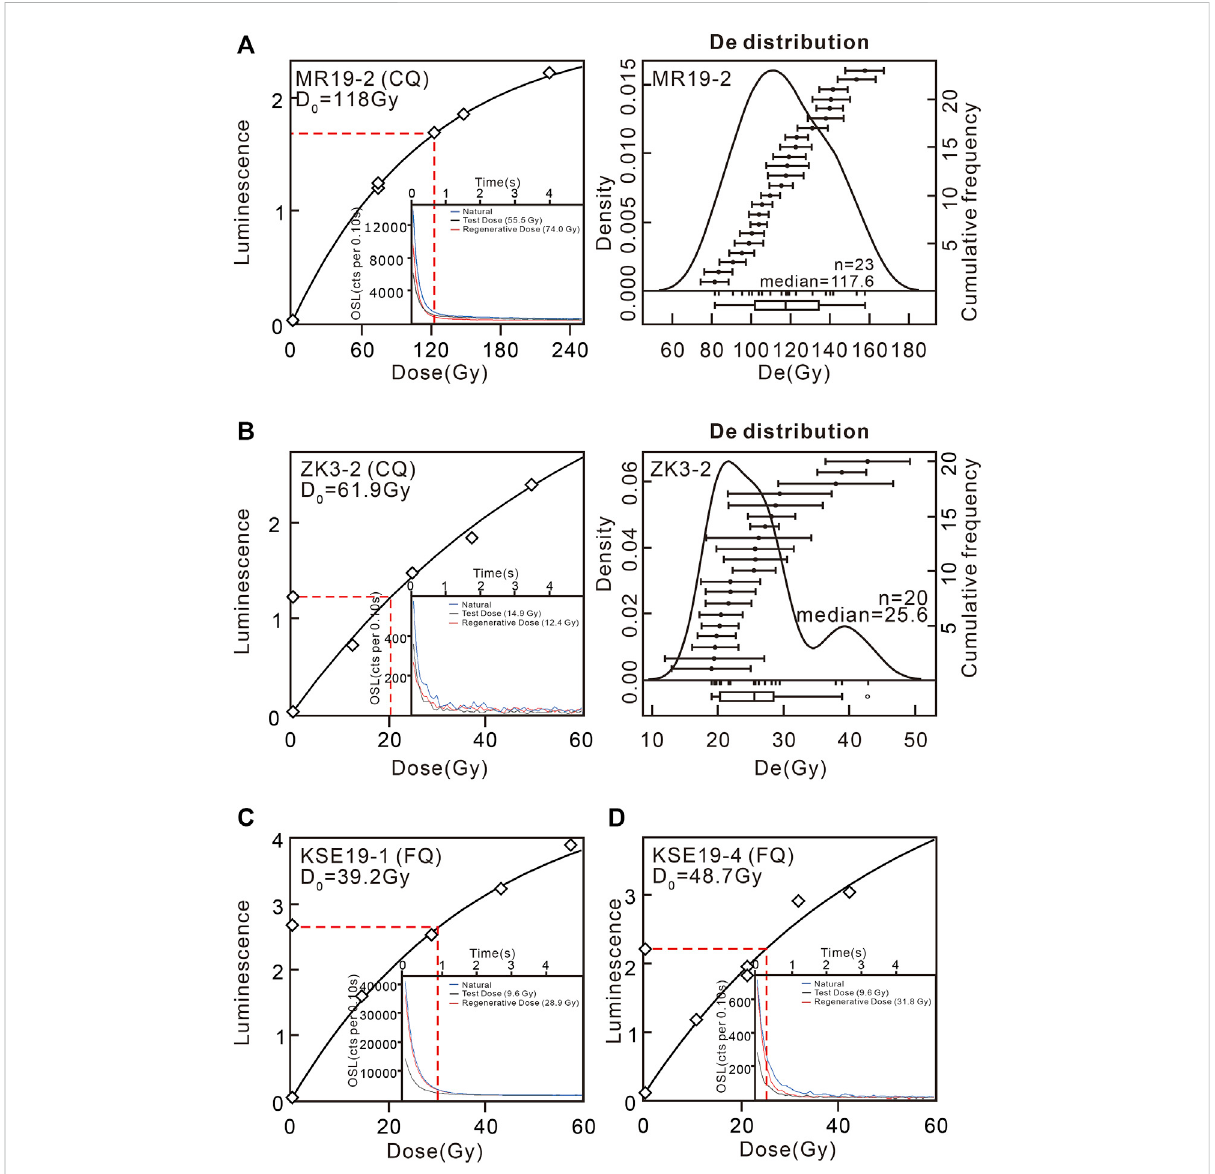
FIGURE 2 Curve plots showing the dose growth, shine down curves (inset) for sample MR19-2, ZK3-2, KSE19-1, and KSE19-4 and dose distribution for sample MR19-2,